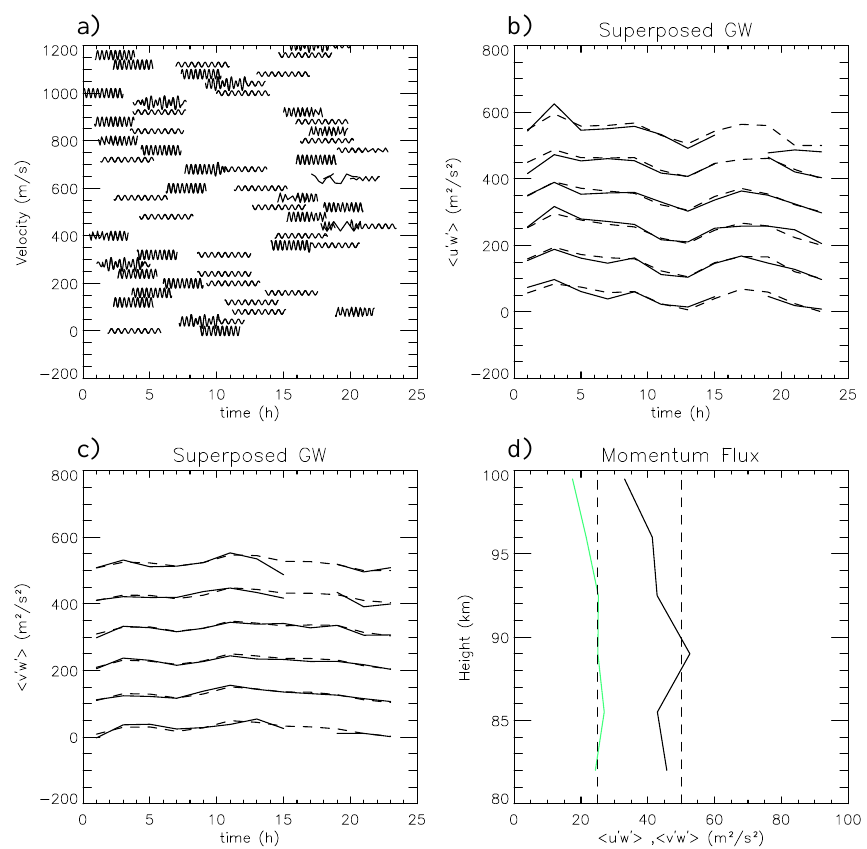
Fig. 16. (a) Vertical velocities showing the occurrence of random superposed GWs throughout the assumed test interval of CP January 2005. Vertical velocities of 20 and 10ms − 1 indicate occurrences of GWs having 3 and 4h durations and propagating in the zonal and meridional directions, respectively (successive daily offsets are 40ms − 1 ). (b) and (c) diurnal variations of momentum flux throughout the composite day. (d) Monthly mean profiles of the zonal and meridional momentum fluxes inferred for January 2005 meteor distributions based on the GW occurrences shown in panel (a) .